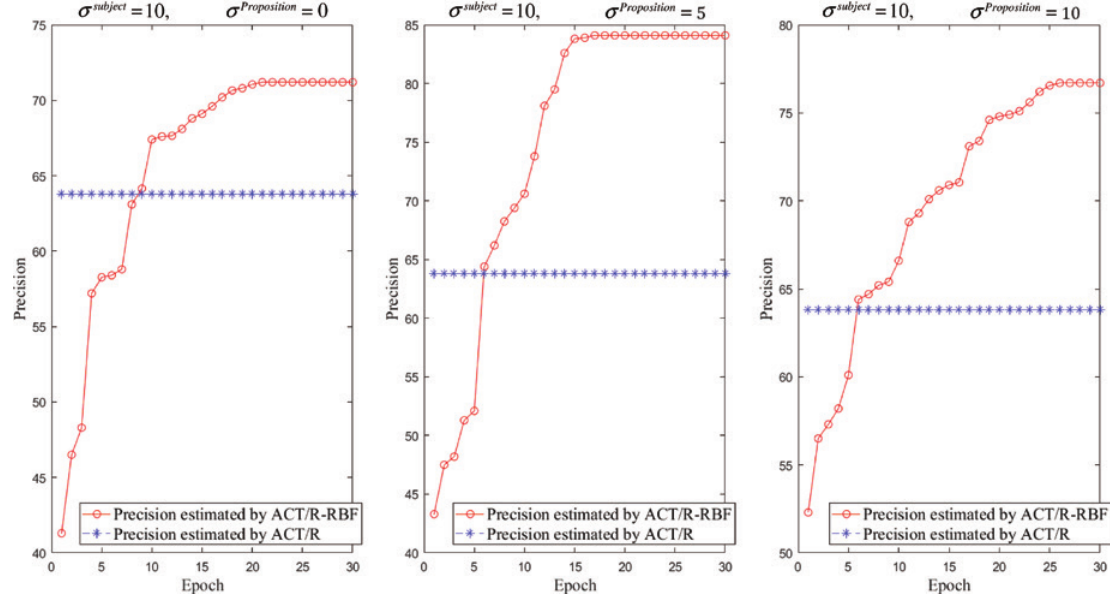
Figure 7: Comparison of the Precision of ACT/R and Hybrid ACT/R-RBF Decision-Making Model for σ Subject =